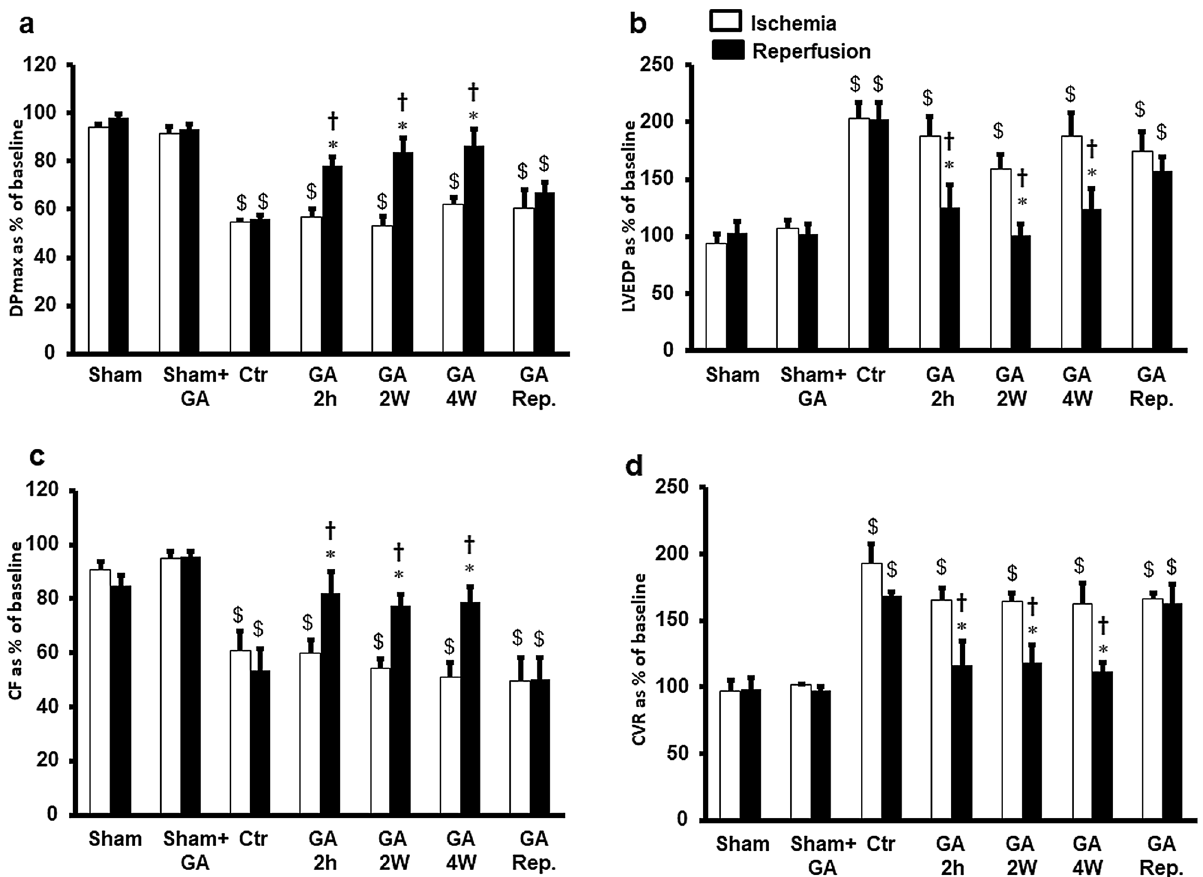
Figure 2. Left ventricle function (DPmax and LVEDP) and coronary vascular dynamics (CF and CVR) during post-ischemic recovery after GA treatment protocols (n = 8). The data were computed after 30 min reperfusion and expressed as the mean ± SEM. DPmax maximum developed pressure, LVEDP left ventricular end-diastolic pressure, CF coronary flow, CVR coronary vascular resistance, Ctr control, Rep reperfusion, GA 2 h Gum Arabic infusion 2 h before sacrifice, GA 2 W Gum Arabic administration for 2 weeks, GA 4 W Gum Arabic administration for 4 weeks, GA Rep . Gum Arabic infusion at reperfusion. *P < 0.05 compared to respective controls, † P < 0.05 compared to the ischemic period and $ P < 0.05 compared to vehicle or GA treated sham controls.